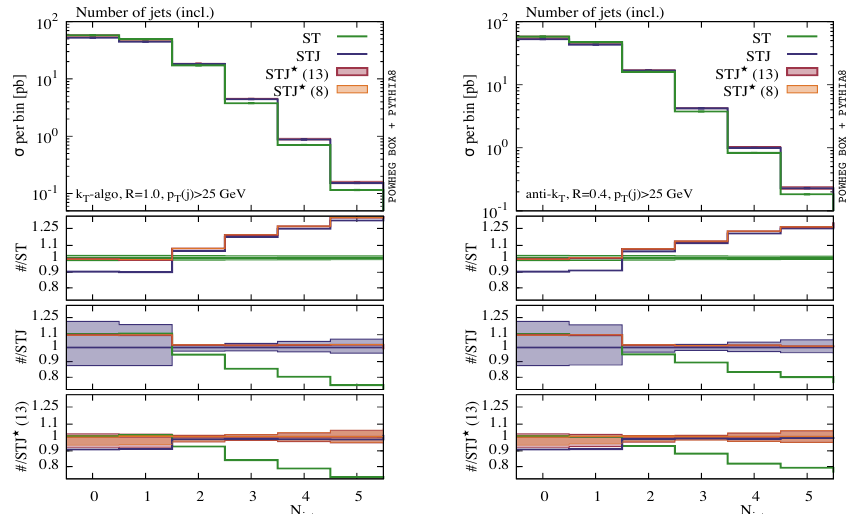
Figure 9 . Inclusive jet cross sections at the 8 TeV LHC. The left-hand plot shows predictions for jets de(cid:12)ned according to the k t clustering algorithm with radius parameter R = 1. The right-hand plot gives predictions for the anti- k t algorithm with R = 0 : 4. The STJ ? (13) program (red) uses a Minlo Sudakov form factor tuned using 13 TeV LHC ST and STJ events (sections 2.4{2.5). The STJ ? (8) program uses a Minlo Sudakov form factor tuned with 8 TeV LHC ST and STJ events.